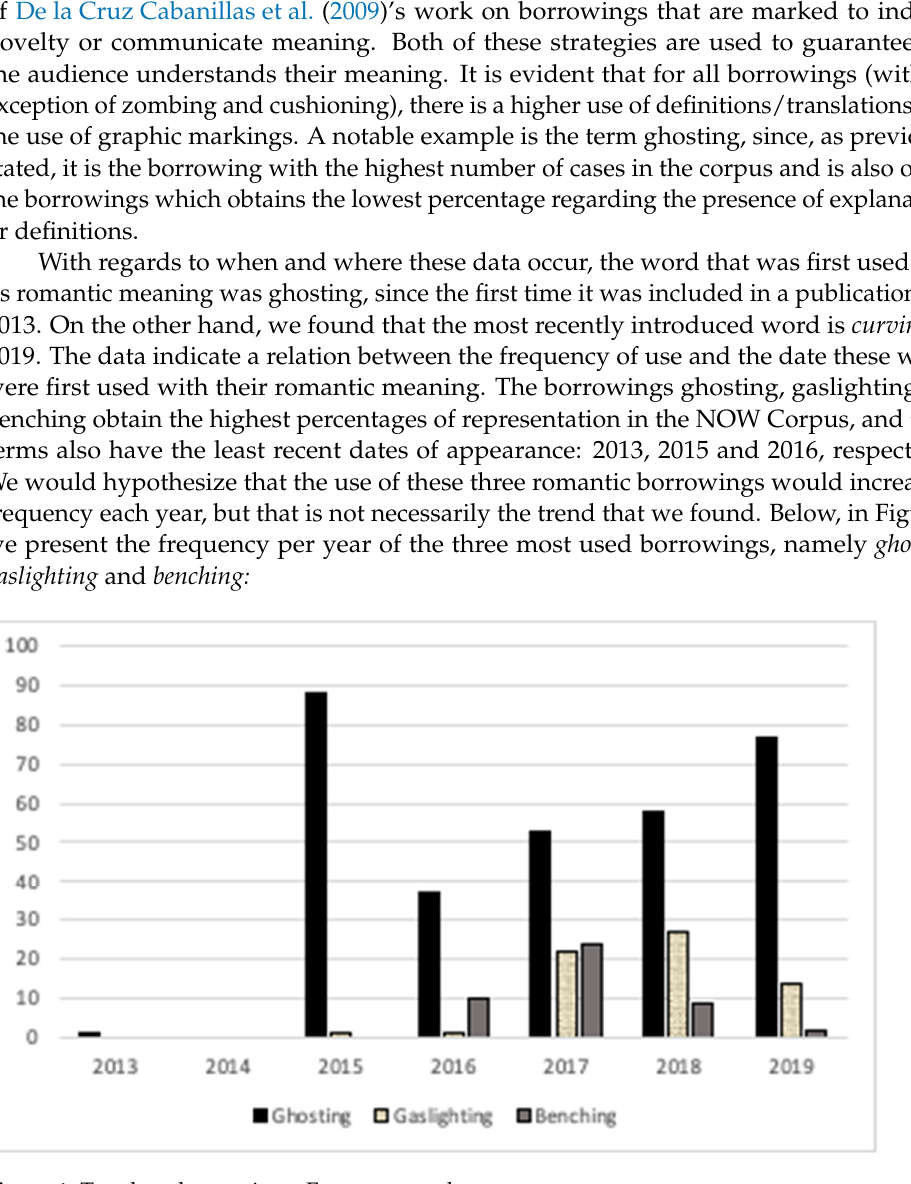
Figure 1. Top three borrowings: Frequency and year.